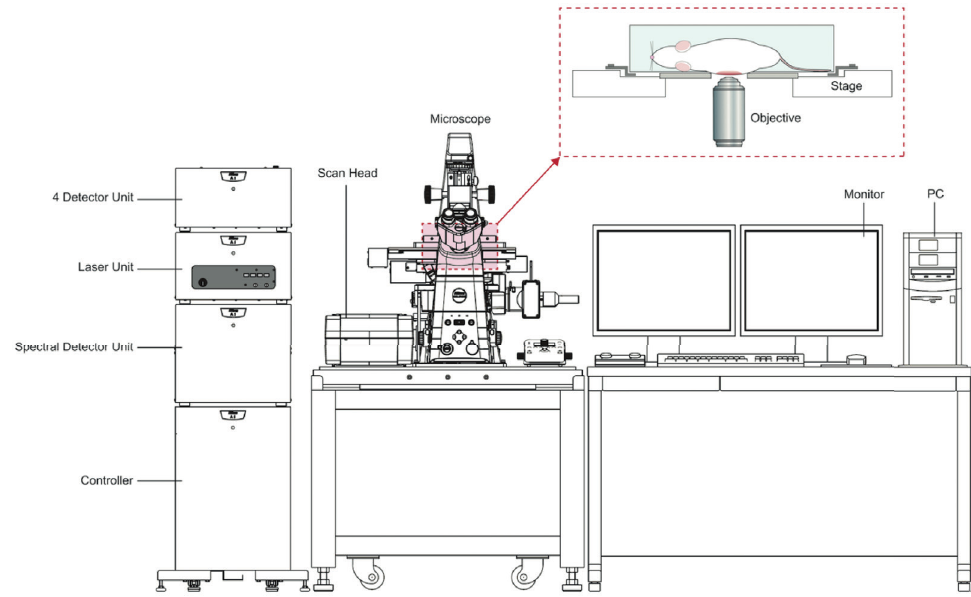
Figure 2 - Schematic representation of microscope setup for confocal intravital microscopy. After the surgical procedure, mouse is positioned on an acrylic stage over the microscope objective for image and/ or video acquisition (enlarged detail of the dashed frame). Images were made in a Nikon A1R confocal microscope.